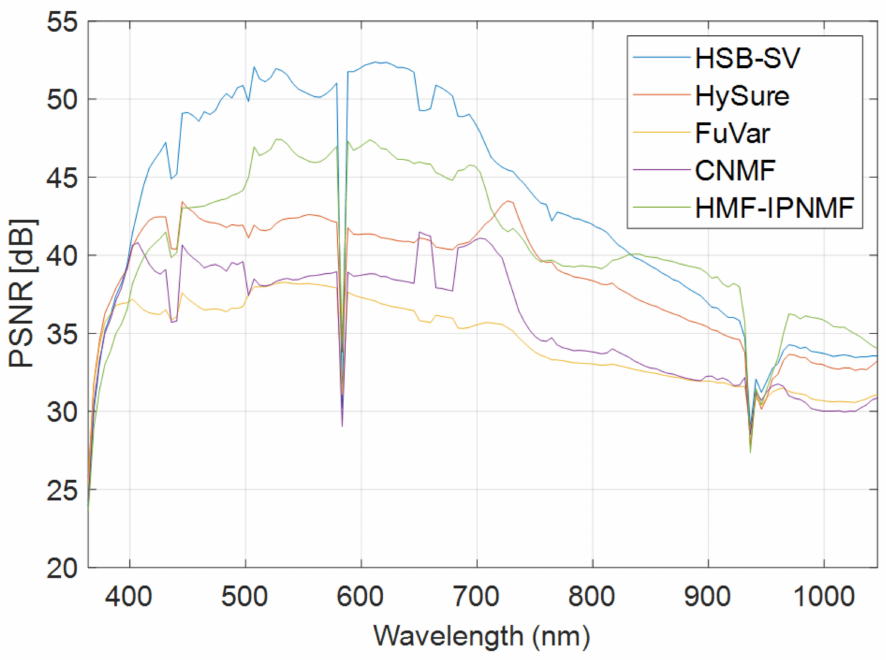
Figure 4. Band-wise PSNR for the synthetic